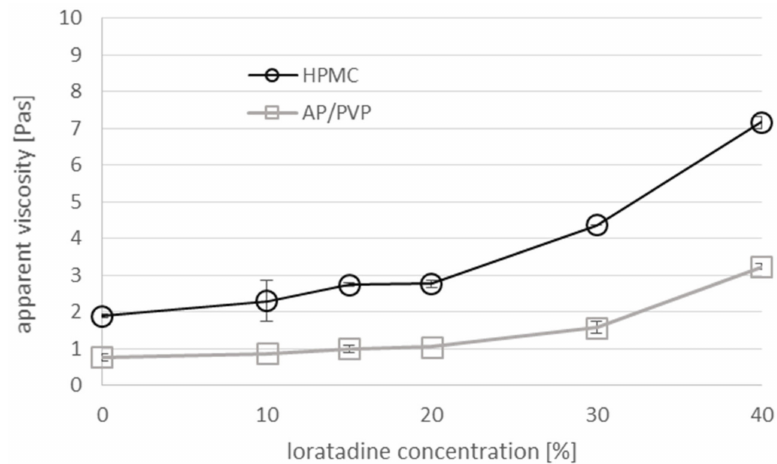
Figure 1. The e ff ect of the concentration of suspended Loratadine (LO) (the final concentration in the ODF of 10%–40% w / w corresponds to 2%–12% in the casting mass) on the apparent viscosity of the hypromellose (HPMC) and polyvinyl alcohol (AP) / polyvinyl alcohol povidone (PVP) casting mass (rotational rheometer, shear rate: 10 s − 1 , n = 3, mean ± SD).